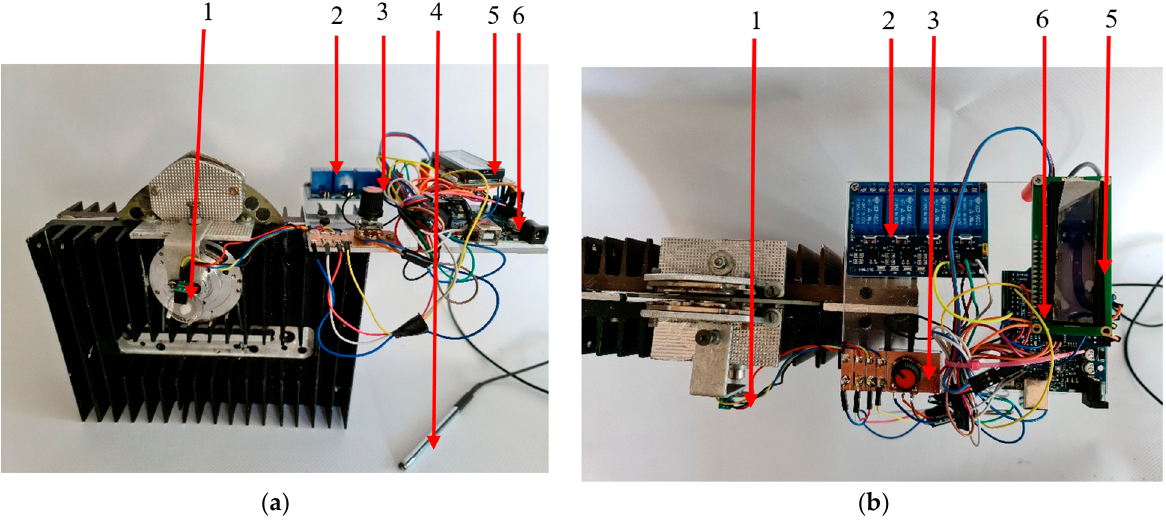
Figure 3. Experimental stand: 1—speed sensor; 2—relay module; 3—potentiometer; 4—temperature sensor; 5—display; 6—programmable microsystem. ( a ) Experimental stand—side view. ( b ) Experi- mental stand—top view.